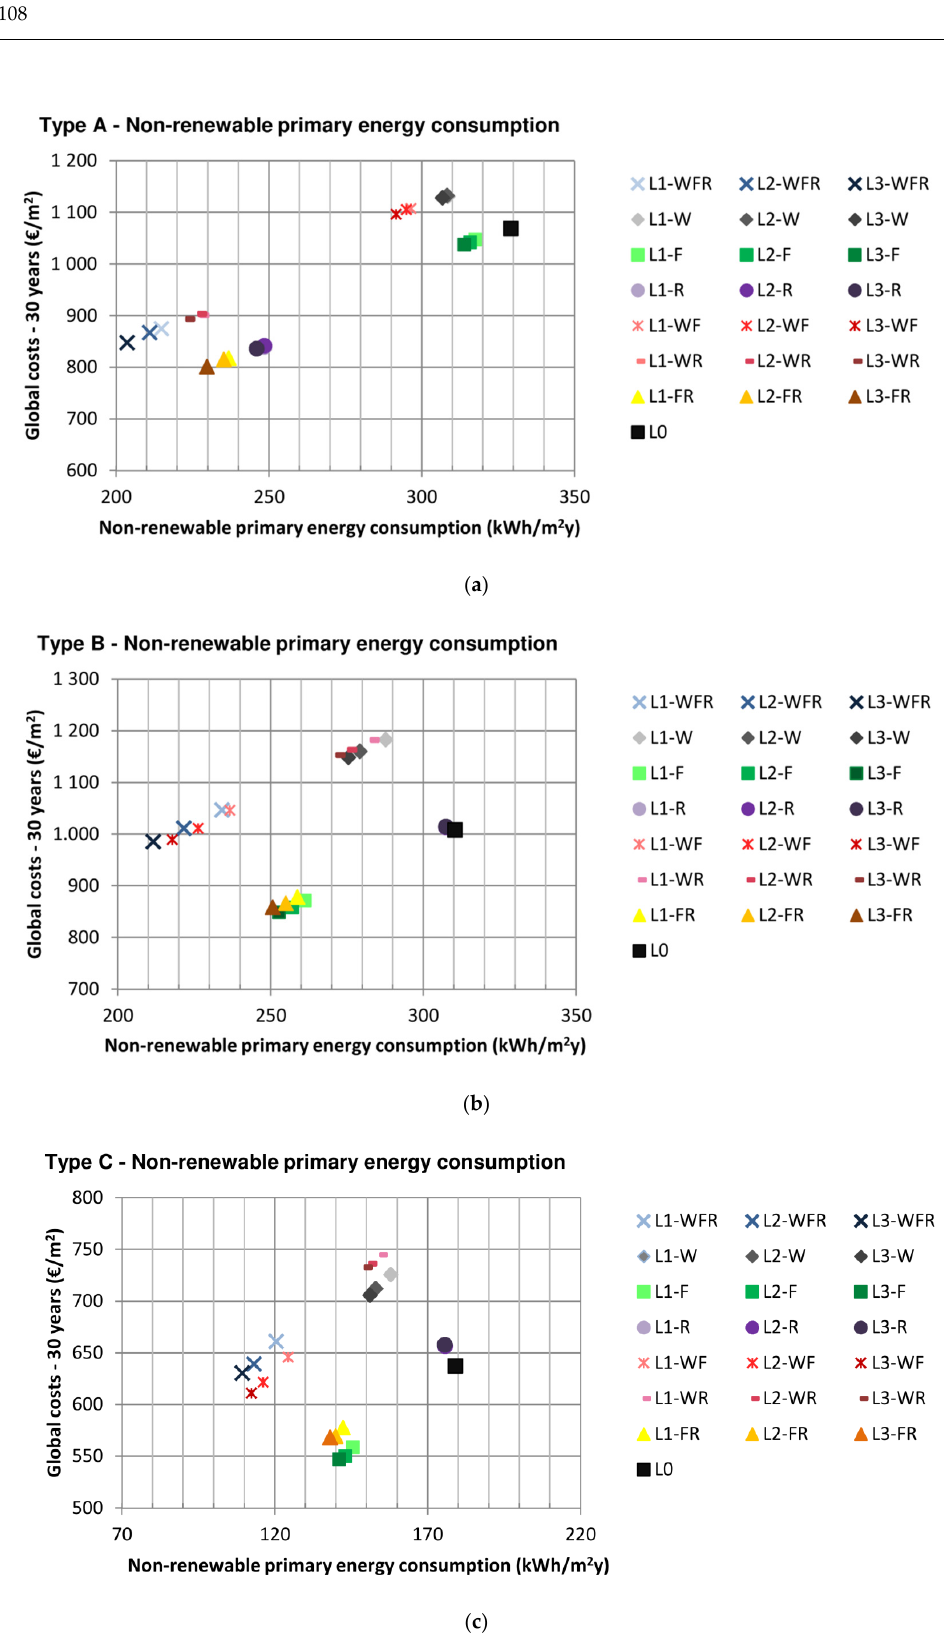
Figure 4. Cost-optimal graphs. Correlation between 30-year global cost per m 2 in the sets of measures proposed and building’s primary energy consumption per m 2 and year, after the intervention, assuming a price increase rate of 1%. ( a )